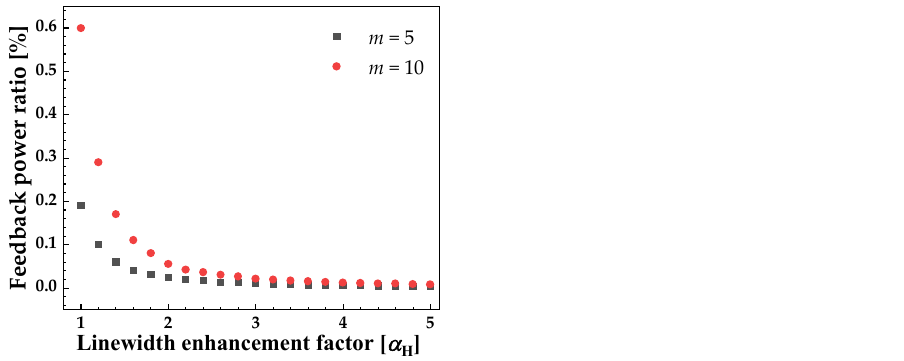
Figure 7. Hopf bifurcation point vs. linewidth enhancement factor under I = 1.1 I th , τ f = 2.4 ns.